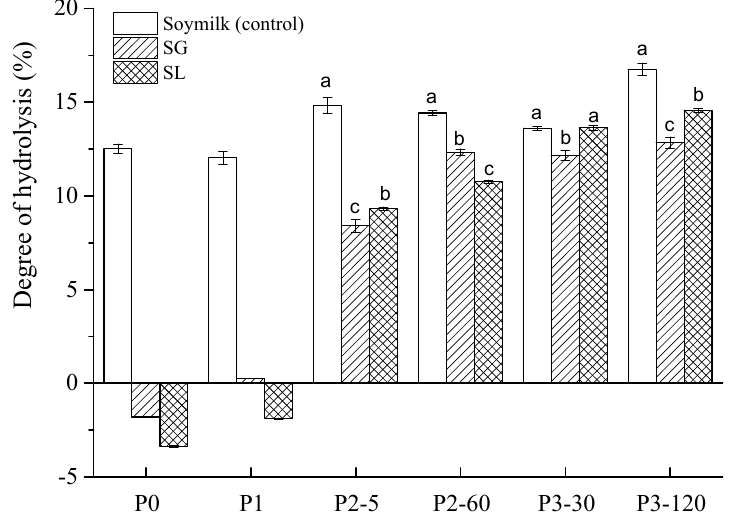
Figure 2. Degree of hydrolysis (DH) of soymilk (control), soymilk gel produced by GDL (SG), and soymilk gel induced by LAB (SL) samples subjected to in vitro GIS. Within the same digestion phase, different lowercase letters indicate significant differences ( p < 0.05). P0 represents the sample before in vitro GIS digestion; P1 represents the sample after buccal digestion; P2-5 and P2-60 indicate samples collected at 5 min and 60 min of gastric digestion, respectively; and P3-30 and P3-120 indicate samples collected at 30 min and 120 min of intestinal digestion,